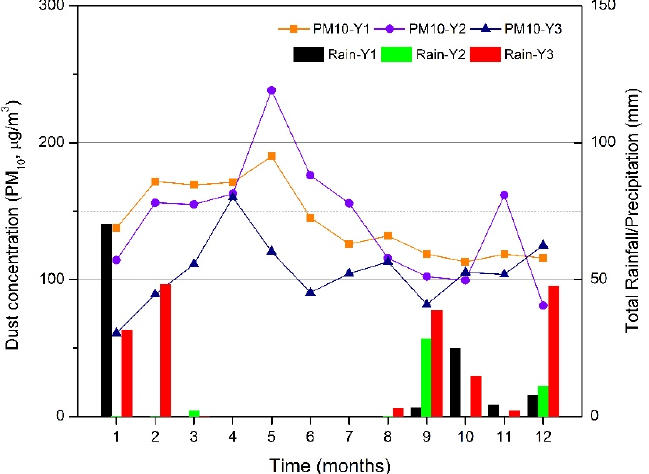
Figure 5. Particulate matter (PM 10 ) concentration and precipitation data at Ras Al Khaimah, UAE.